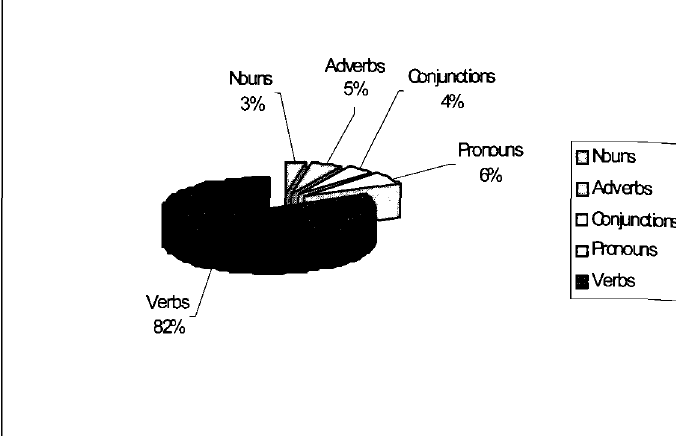
Figure 1: Pie chart illustrating the percentage of the words according to word classes